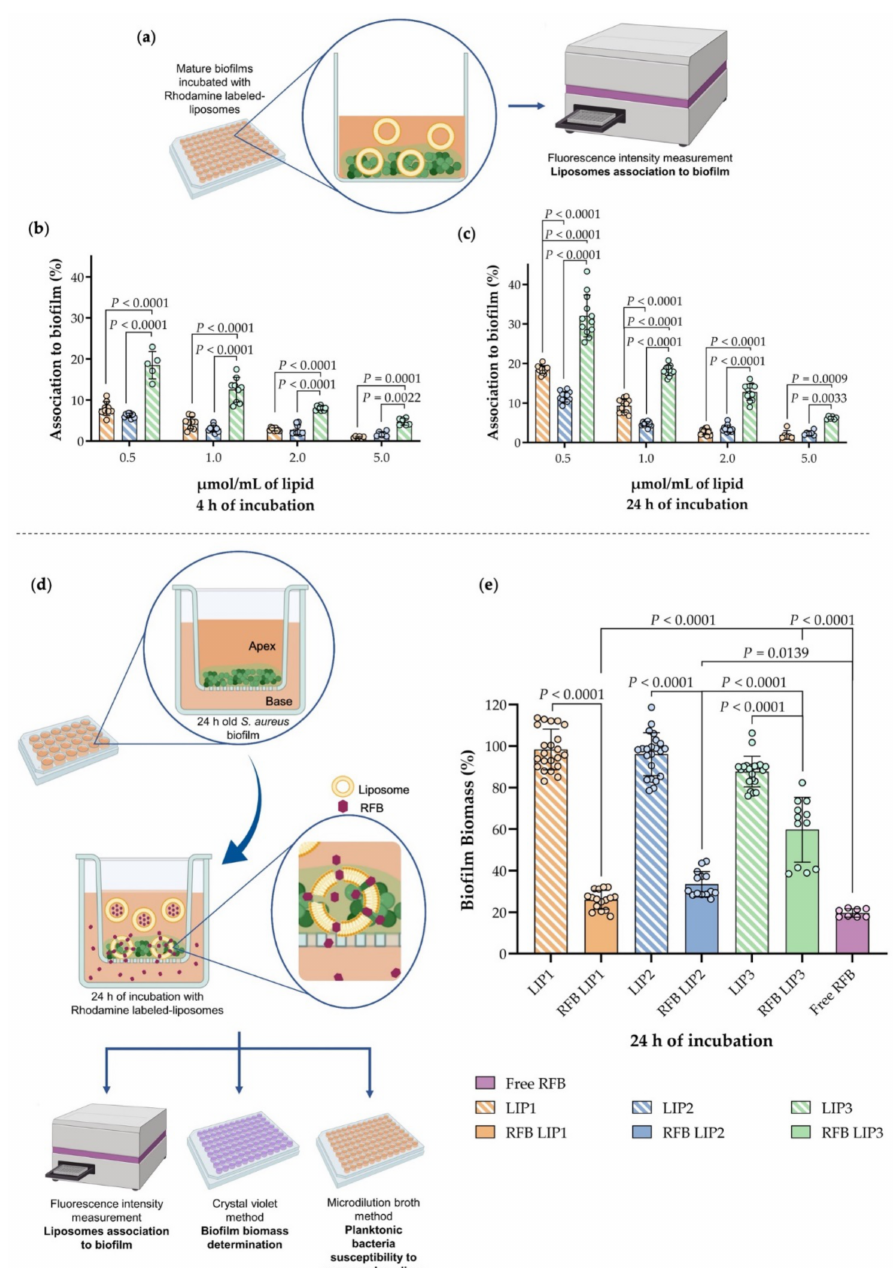
Figure 4. ( a ) Schematic representation of the experimental protocol for the liposome-biofilm interaction evaluation, performed in 96-well cell culture plate with rhodamine labeled-liposomes (LIP1, LIP2 and LIP3), at 0.5, 1, 2 and 5.0 µ mol/mL of lipid, against mature MSSA biofilm. The presence of liposomes was evaluated by fluorescence intensity measurement (Spectrofluorimetry, λ excitation = 540 nm; λ emission = 620 nm); ( b ) Incubation for 4 h and ( c ) incubation for 24 h. Results are expressed as mean ± SD of at least three independent experiments. Statistical comparisons were determined by two-way ANOVA (Tukey’s multiple comparisons test) analysis of variance compared between formulation groups. ( d ) Schematic representation of biofilm transwell model. Biofilm grew in a porous membrane cell culture insert (apex), placed on 24-well cell culture plate (base). RFB-loaded and unloaded in rhodamine labelled-liposomes (RFB LIP1, RFB LIP2, RFB LIP3, LIP1, LIP2, LIP3,) were incubated with mature MSSA biofilm in the apex, for 24 h. Liposomes internalization was evaluated by spectrofluorimetry ( λ excitation = 540 nm; λ emission = 620 nm), biofilm biomass was determined by CV assay and planktonic susceptibility in the recovered medium by broth microdilution method. ( e ) Biofilm biomass (%) quantification of biofilm transwell model. Results are expressed as mean ± SD of two independent experiments. Statistical comparisons were determined by one-way ANOVA (Bonferroni’s multiple comparisons test) analysis of variance compared between formulation